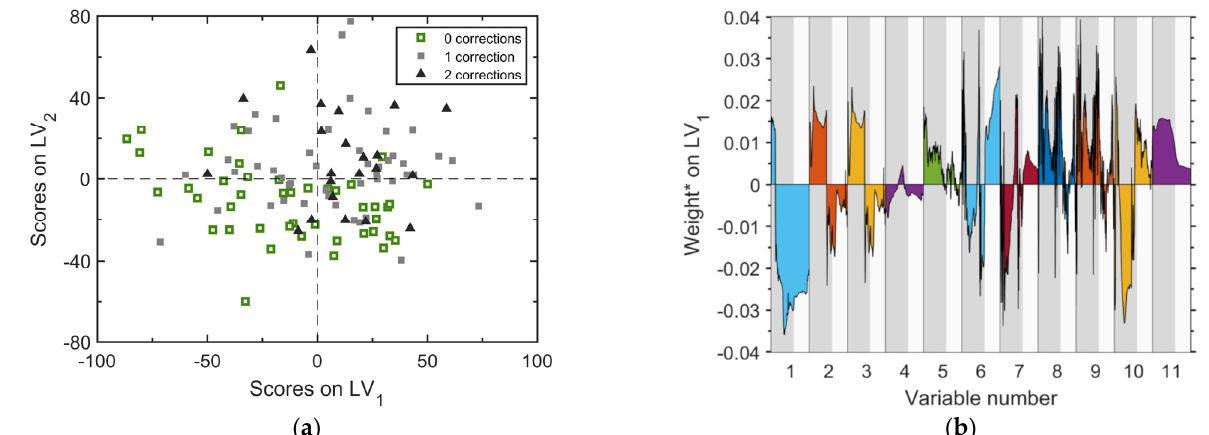
Figure 5. Two-component projection to latent structures discriminant analysis (PLS-DA) model for R203. ( a ) Scores plot (each marker represents a charge to R203, and the different shapes of the markers denote a different number of required corrections); ( b ) time trajectories of the weights for the first latent variable for each process variable (the variable numbering is reported in the Appendix A). For each variable in ( b ), the grey-shaded area represents the charging stage, whereas the white-shaded area is the reaction stage.